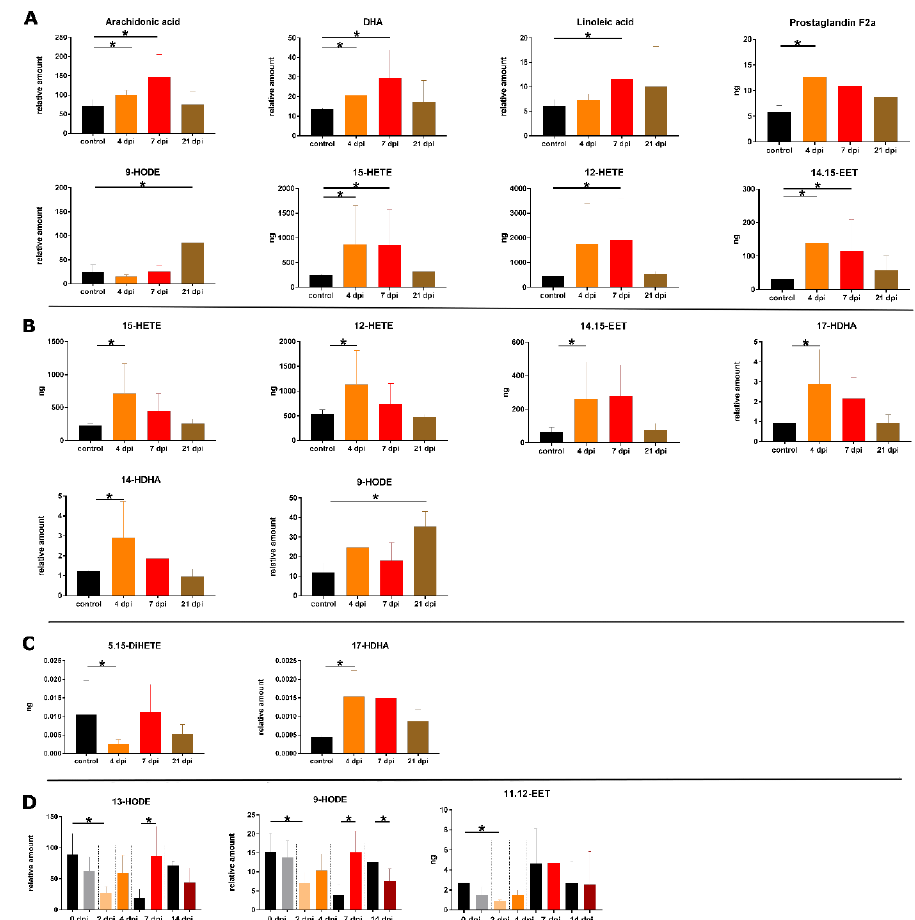
Figure 2. Overview of significant changed amounts of eicosanoids during infection in the spleen ( A ) and the lung ( B ) per g sample; the BALF per 5 mL ( C ) and blood plasma per mL ( D ). Asterisks indicate significant changes ( p -value ≤ 0.05) using Mann-Whitney U test for control ( n = 3 for tissue and BALF, and n at least 6 for plasma) and infection ( n = 5 for tissue and BALF, and n at least 6 for plasma). The following color pattern was used: control (black), 4 dpi (orange), 7 dpi (red) and 21 dpi (brown) for A – C . For plasma ( D ) control samples for all days were illustrated in black and plasma samples from infected animals were shown for 0 dpi (grey), 2 dpi (light orange), 4 dpi (orange), 7 dpi (red) and 14 dpi (dark